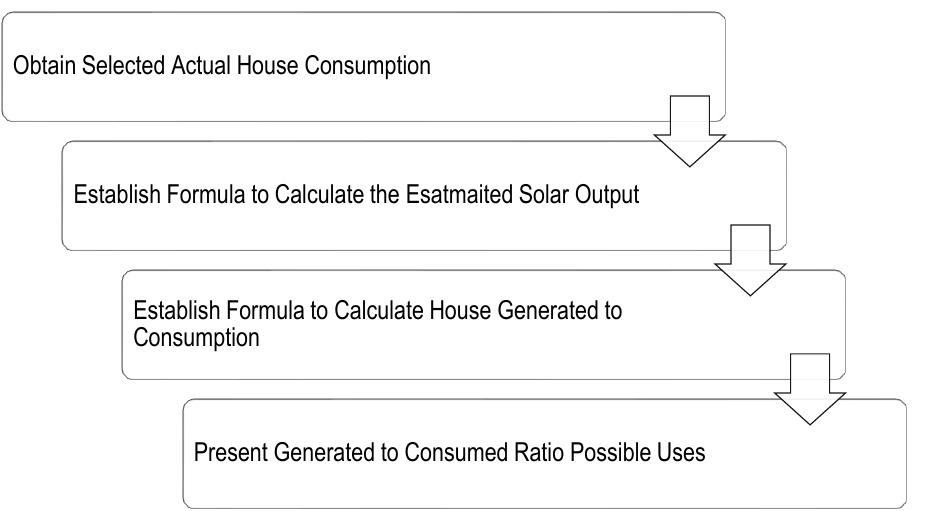
Figure 2. Research Design.